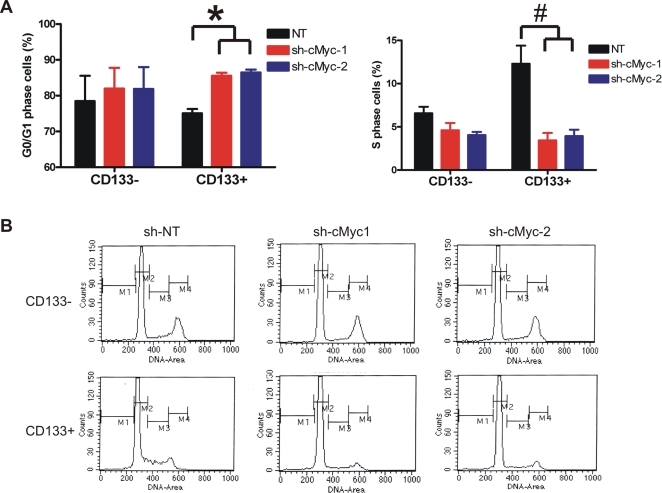
c-Myc induces cell cycle arrest of glioma cancer stem cells.(A, B) Early passage (<P5) T3359 glioblastoma CD133− or CD133+ cells were infected by lentivirus directing expression of either non-targeting shRNA (NT) or c-Myc specific shRNAs (sh-1 and sh-2). Three days after infection, cells were fixed in 75% ethanol and labeled with 10 µg/ml propidium iodide. Cell cycle distribution was determined by flow cytometry. (A) Data were generated from three independent experiments. *, p<0.05; #, p<0.001 with one-way ANOVA comparison of the control groups to the corresponding c-Myc knockdown groups. (B) Representitive FACS plots are displayed. M1-sub G0 phase; M2-G0/G1 phase; M3-S phase; M4-G2/M phase.